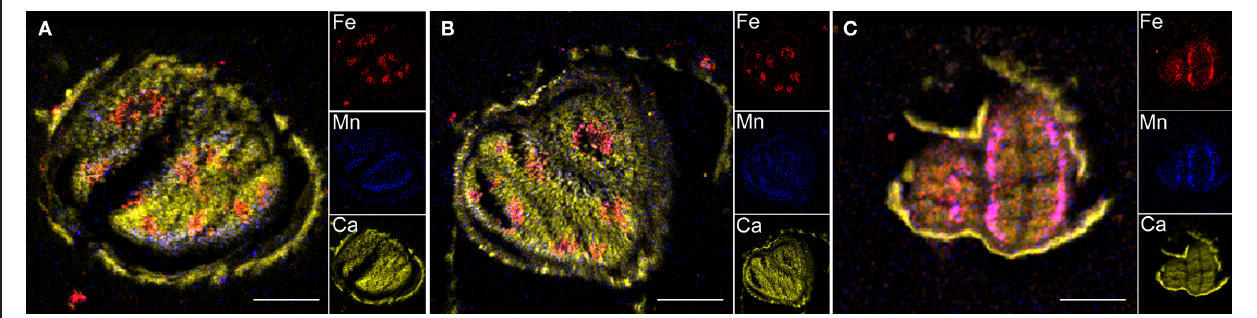
FIGURE 4 | Transversal sections of Arabidopsis thaliana dry and imbibed seeds. Specific distributions of Fe, Mn, and Ca in section of WT (A) and nr3nr4 (B) imbibed seeds and vit1-1 (C) dry seeds are shown overlaid (large image) and separately (small images). Scale bar: 100 µ m; red, Fe; blue, Mn; yellow, Ca.